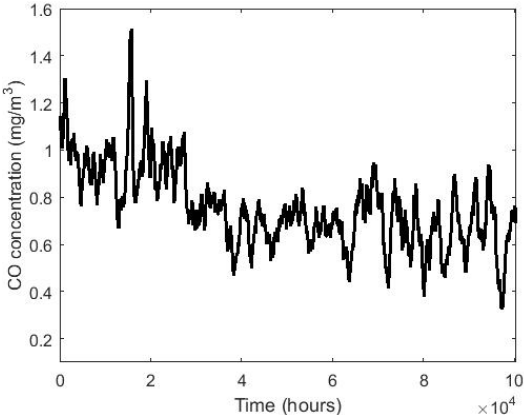
Figure 2. Moving average of the time series consisting of the values of the CO concentration from 1